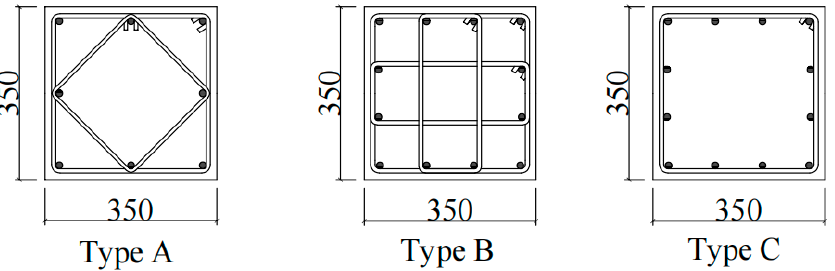
Figure 5. Cross-sectional details of specimen.